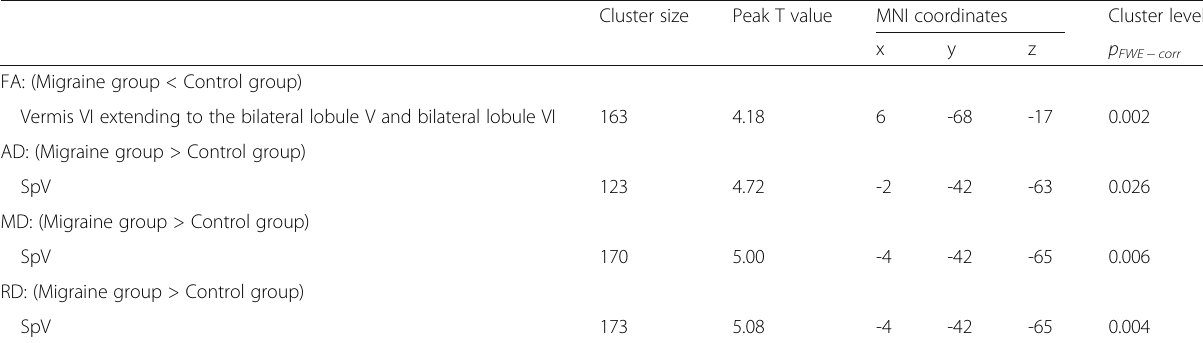
Table 2 Brain regions with significant differences in diffusion characteristics between MWoAs and healthy